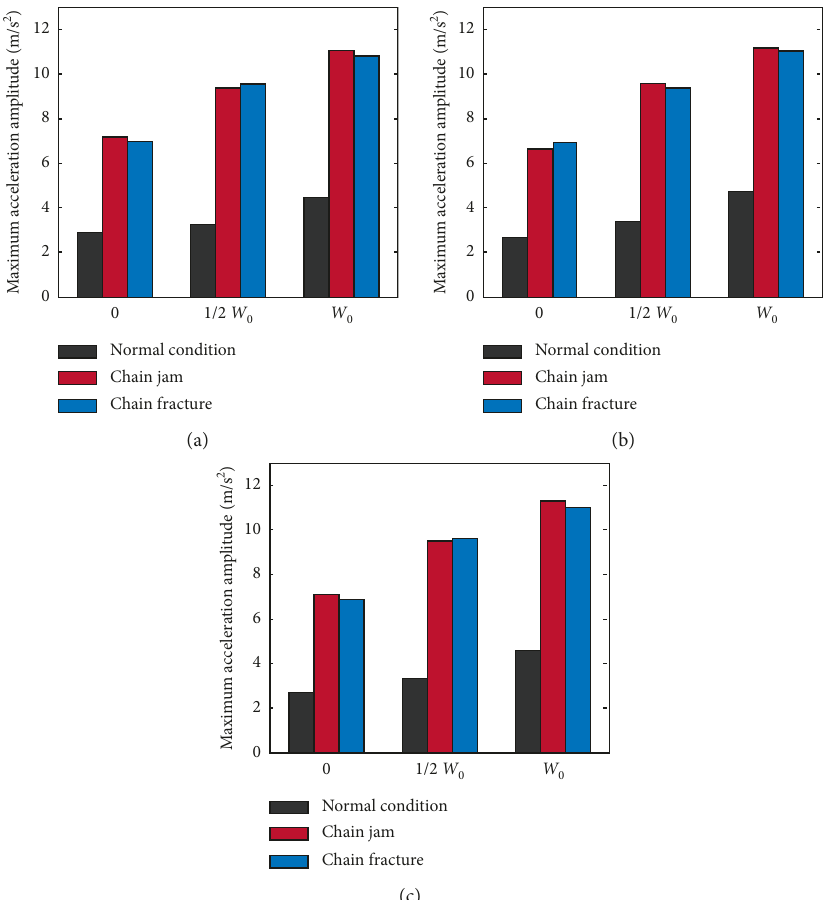
Figure 12: Statistical results of the maximum vibration amplitude at different measuring points: (a) #1; (b) #2; (c)